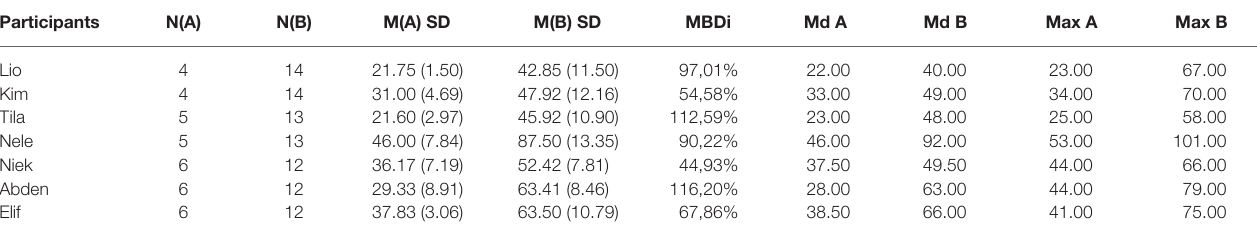
TABLE 5 | Descriptive data for